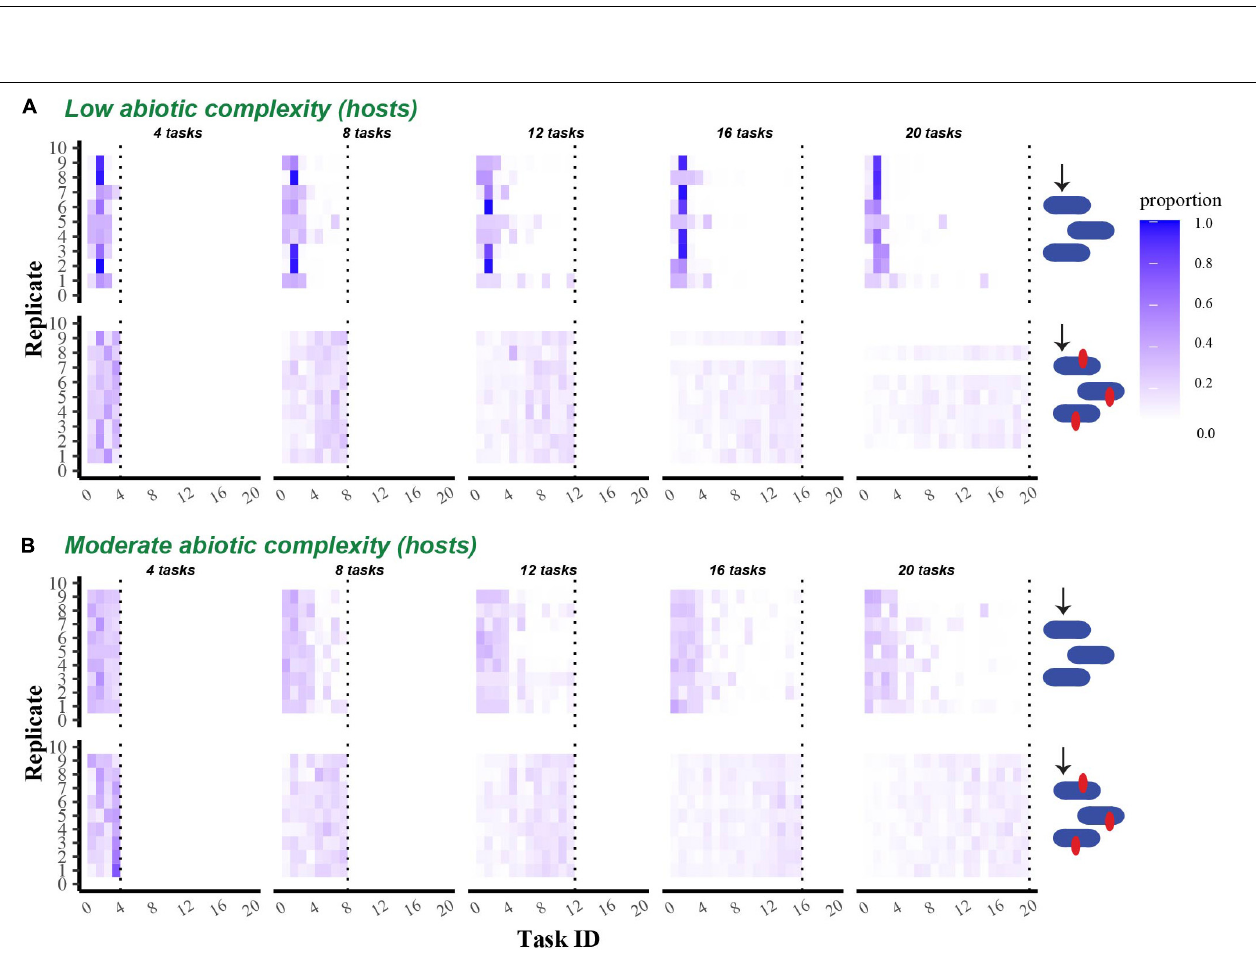
FIGURE 4 | Final phenotypic diversity of hosts. Boxplots show phenotypic diversity (summarized as Shannon’s diversity index) of host populations at the end of 300,000 updates in populations evolving in a single resource environment (A) , a four-resource environment (B) and in environments of increasing ecological complexity (C) . Data from non-coevolving populations is shown in blue, while data from coevolving populations is shown in red. Only data from those host populations in which parasites did not go extinct are shown.